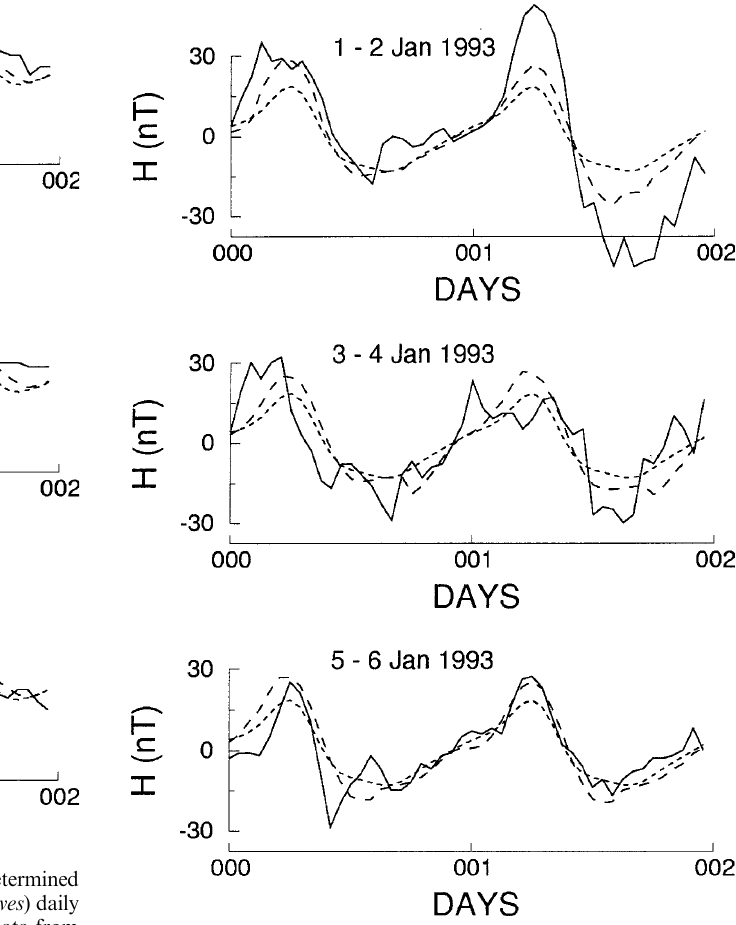
Fig. 7. A comparison of curves similar to those in Fig. 7, but for a sequence of six days where all K indices were in the range 2–4. The curves shown are for the H-component at HER for the interval 1–6